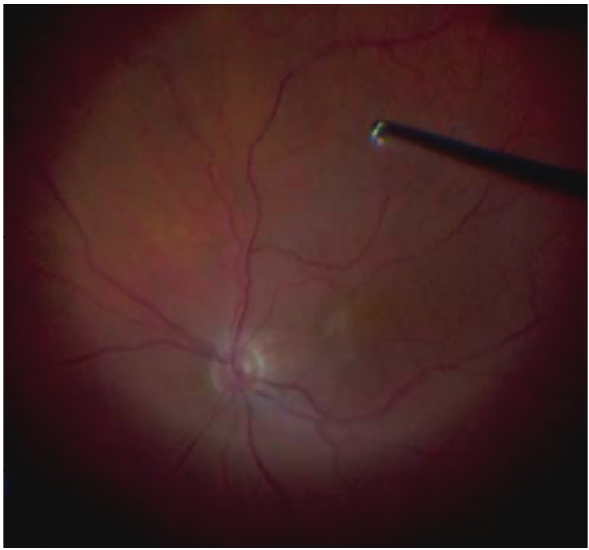
Figure 3: Limited vitrectomy: posterior vitreous detachment in- duction with “core vitrectomy.”